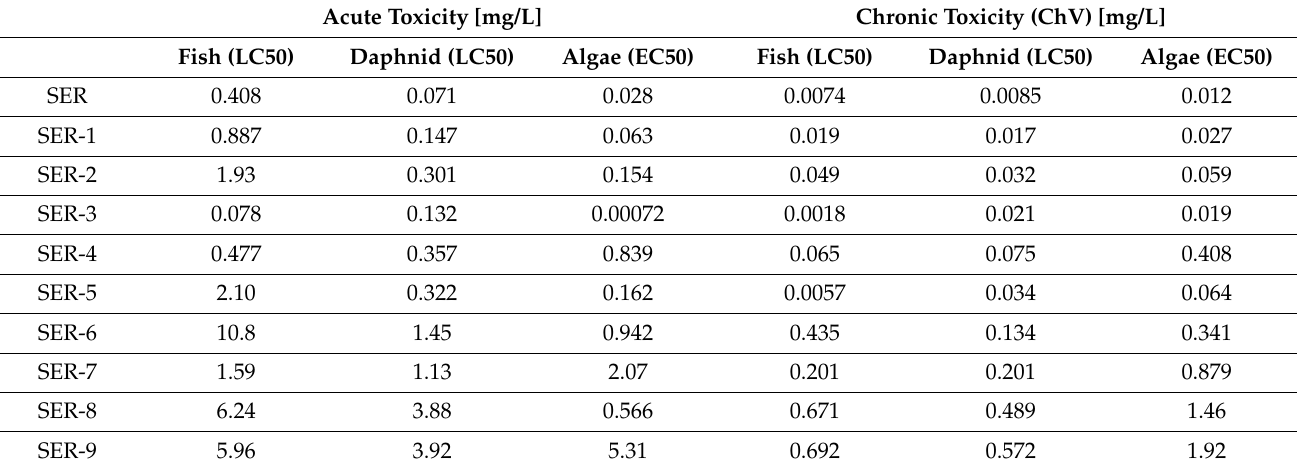
Table 5. Toxicity predictions for SER and its transformation products using ECOSAR software. Acute Toxicity